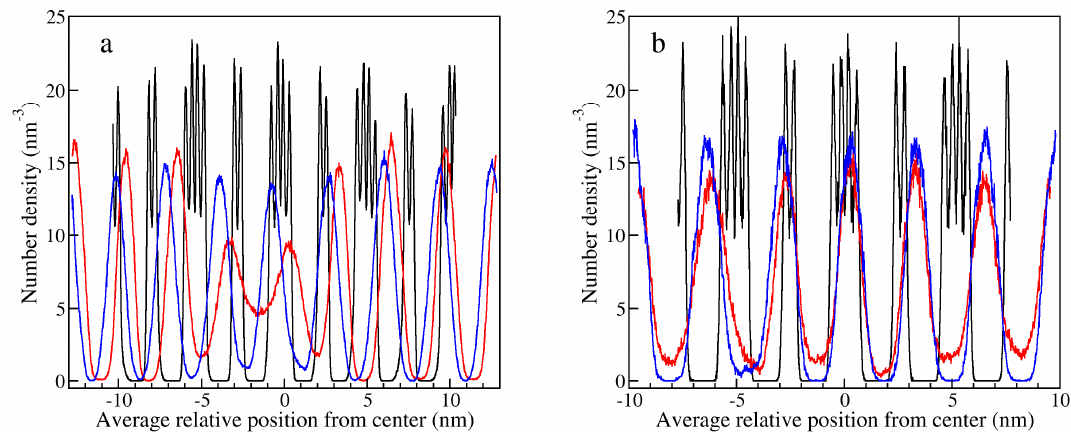
Figure 9. Average number densities of nitrates along the z axis for ( a ) the DB structure with 384 ion pairs at 530 K in the crystal phase (black), at 530 K after the solid-LC transition (red), and at 560 K in the equilibrated LC phase (blue); and ( b ) for the DB structure with 648 ion pairs, in the crystal phase (black), after the solid-LC transition when the system was not well equilibrated (red), and in the equilibrated LC phase (blue), all at 530 K.